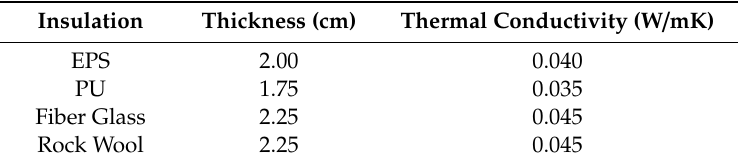
Table 6. Insulation thickness calculated according to NBR 15220 [25].